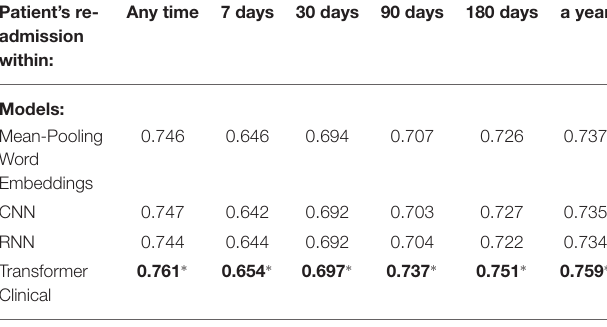
TABLE 10 | Comparison of the deep neural models on the head (first 512 tokens) portions of discharge summaries for the re-admission prediction